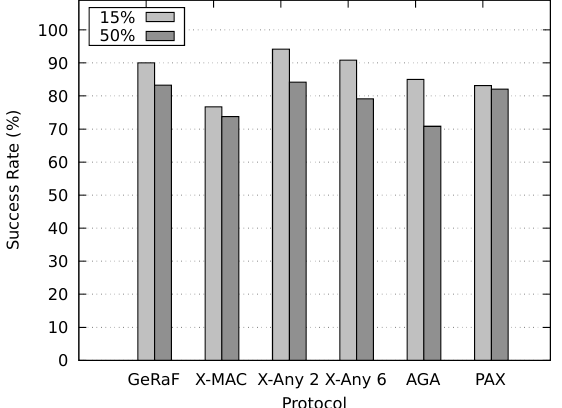
Figure 14. Packet delivery success rate for concurrent flows transmitted in persistent mode, for data packet durations t data = 50% t cycle and t data = 15% t cycle , SD = 650